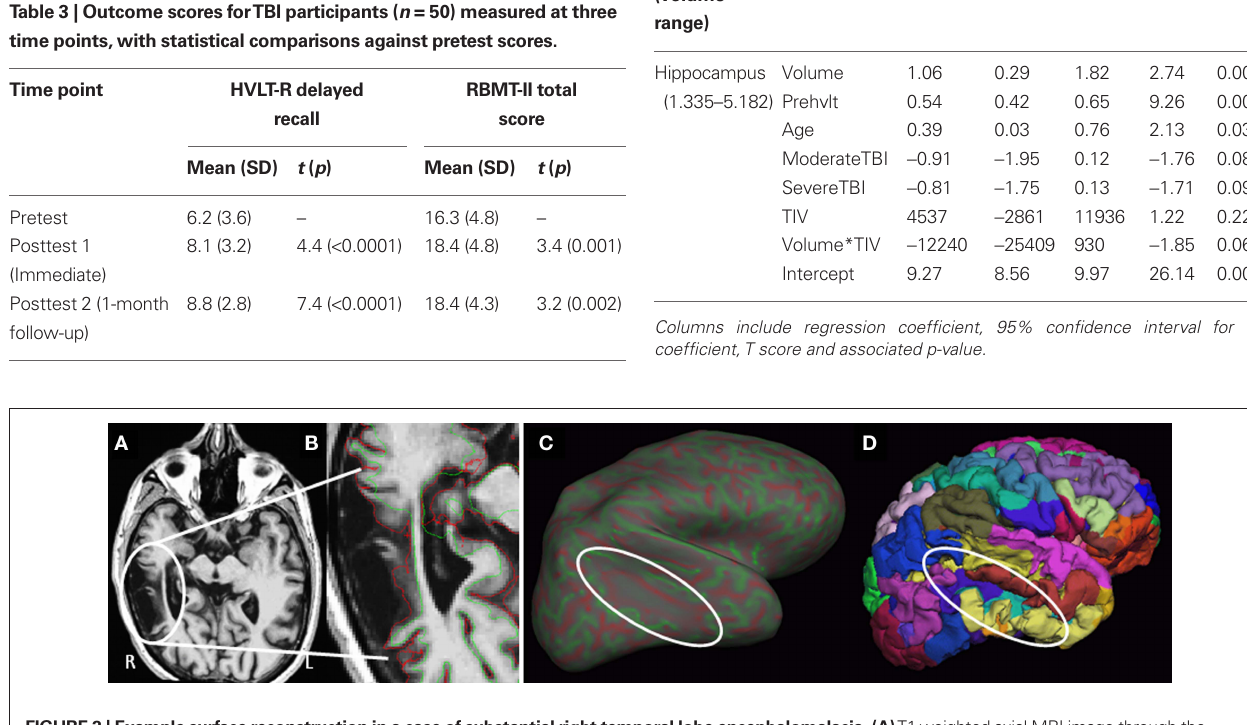
(C) Inflated right hemisphere showing curvature (reds = depth of sulci, greens = peak of gyri), with minimal curvature in the region of degeneration. (D) Re-folded surface with individual regional cortical labels (colors).